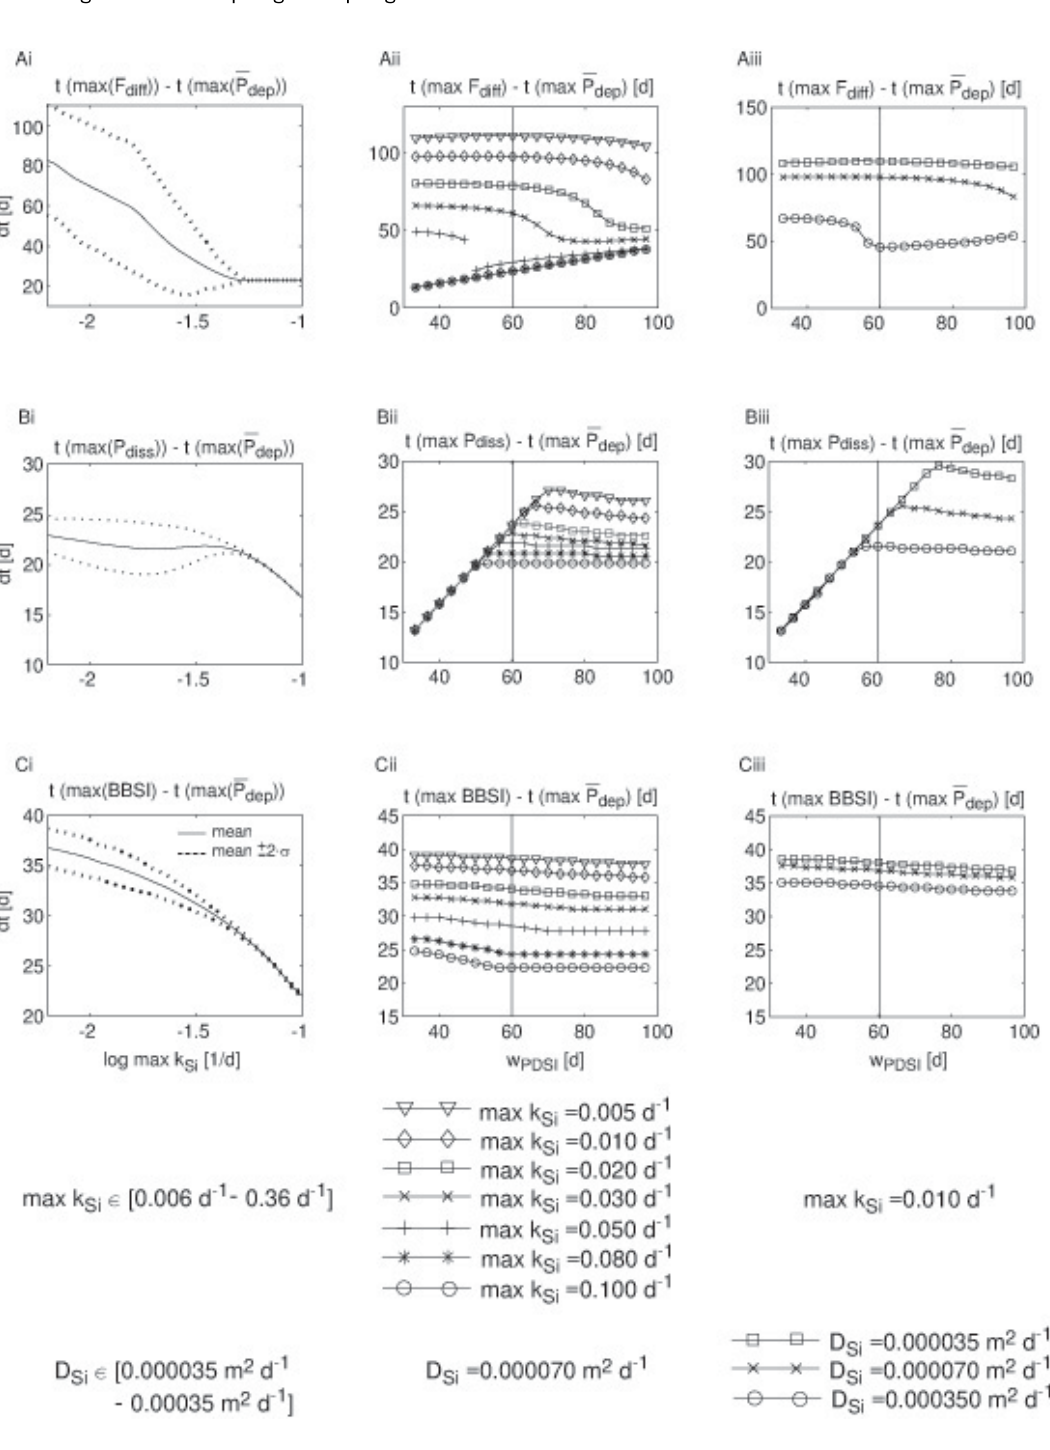
Fig. 5. Distribution of time lags between (A) maximum diffusive flux t( max F diff ) and maximum deposition rate t( max P dep ) , (B) time lag between maximum dissolution rate t( max P diss ) and maximum deposition rate t( max P dep ) and (C) time lag between maximum BBSI content t( maxBBSI ) and and maximum deposition rate t( max P dep ) over the i) logarithm of maximum dissolution rate constants, ii) and iii) different length of the silica depletion in the water column w PDSI . Shown are the results of i) 1000 model runs with randomly drawn parameter vectors (Table 2 Sensitivity I), ii) 500 randomly drawn w PDSI and 7 different max k Si (Table 2 II) and iii) 500 randomly drawn w PDSI and three different D Si (Table 2 III). The w PDSI used in the first sensitivity experiment (i) is indicated in ii) and iii) by a solid